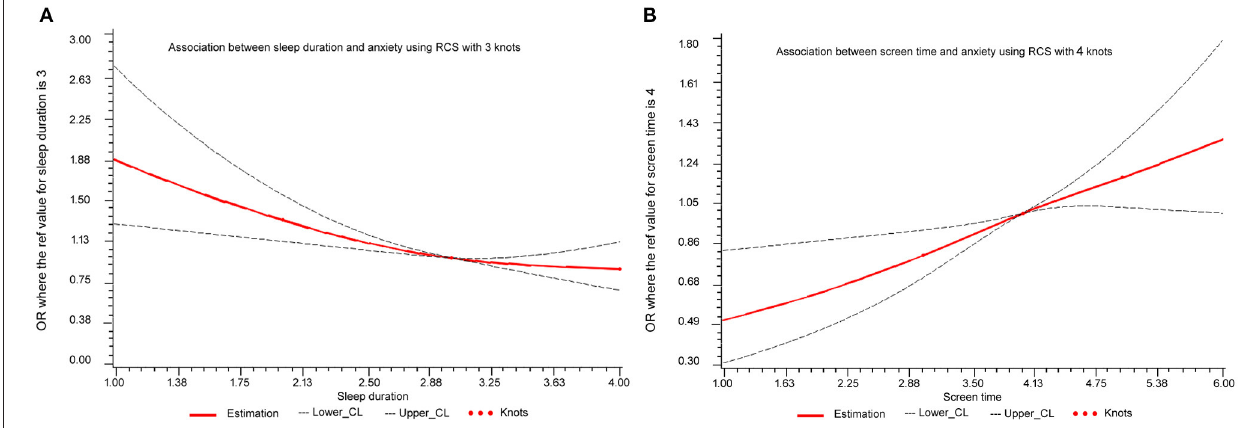
FIGURE 1 | Dose-dependent association of (A) sleep duration and (B) screen time with anxiety.